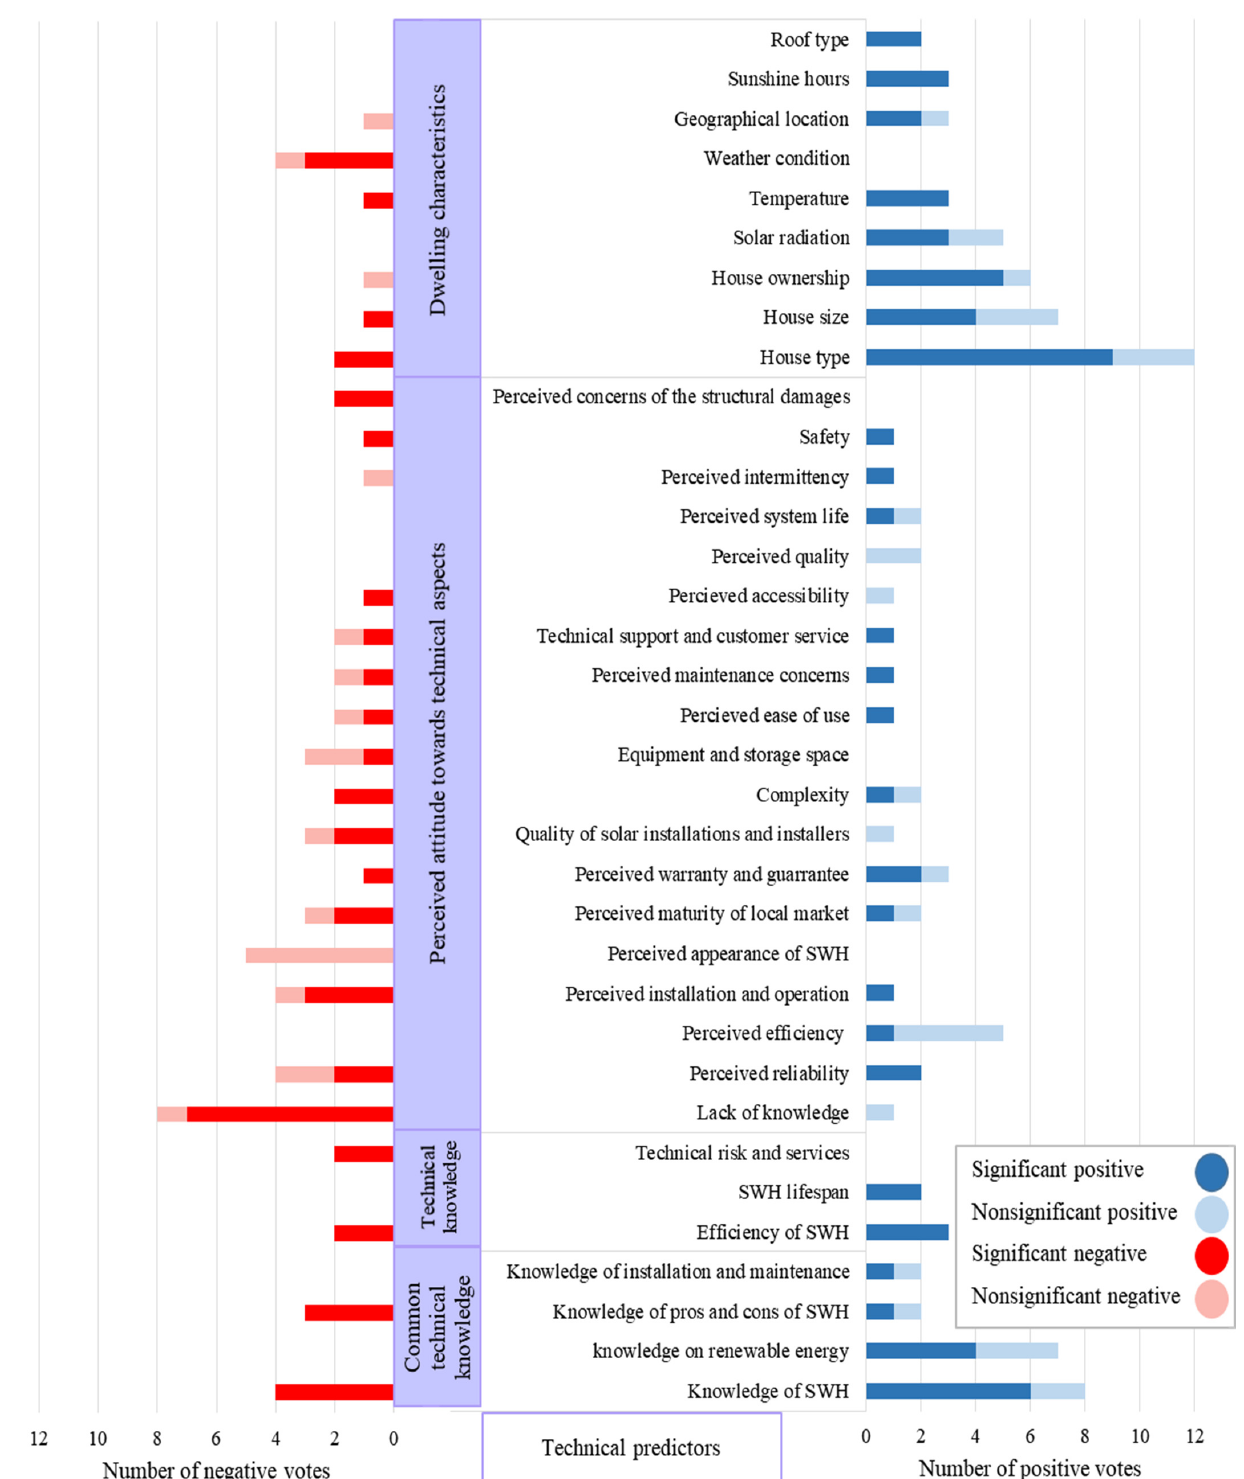
Figure 7. Vote-counting outcome for financial variables affecting the adoption of solar systems by households. Results are narrowed to variables studied in at least two studies.